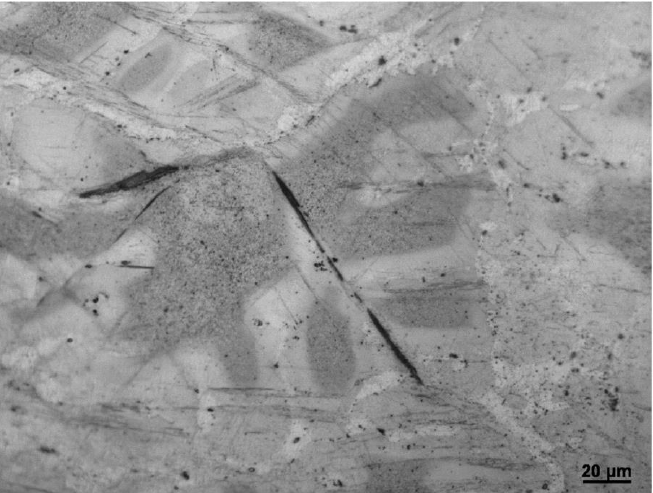
Figure 17. The crack in the P6 specimen.